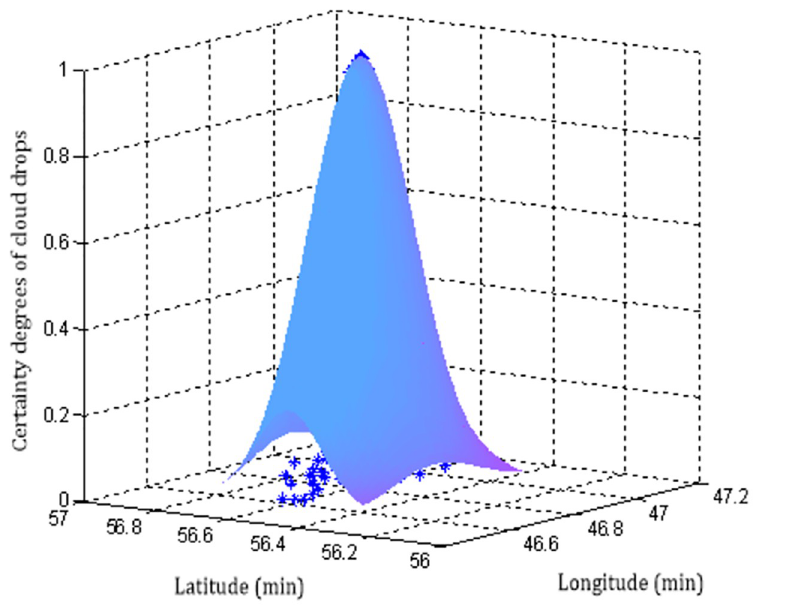
Fig 10. The maximum boundary surface of sampling point No.14.